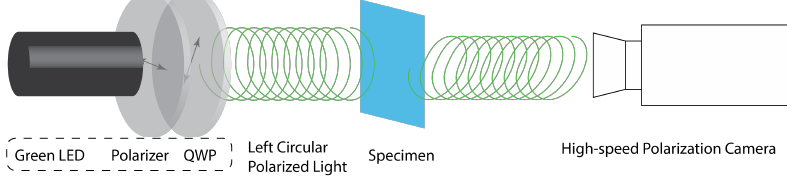
Figure 1. Schematic of the high-speed polarization camera’s optical train.